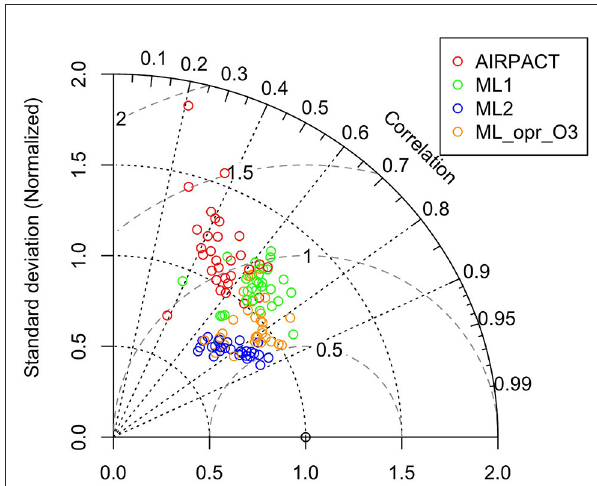
FIGURE5 Taylor diagram of MDA8 O 3 at the AQS sites throughout the PNW. Each circle symbol represents an AQS site, and the red color is for AIRPACT, green for ML1, blue for ML2, and yellow for ML_opr_O 3 . Note that centered RMS difference is proportional to the distance from the point on the x-axis (standard deviation) marked with an open circle.